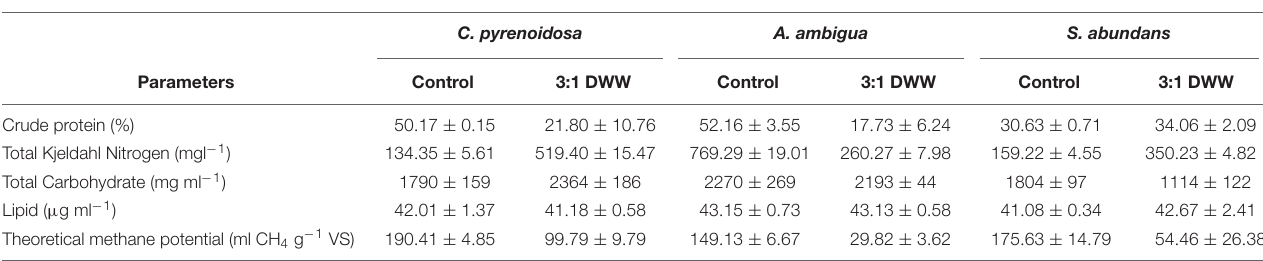
FIGURE 5 | Phosphate reduction at alternate of 5 days in 3:1 ratio of DWW treated with A. ambigua, C. pyrenoidosa and S. abundans ( (cid:7) -control; (cid:4) - C. pyrenoidosa ; (cid:78) - S. abundans ; - A. ambigua ) (Values represent the mean ± SD of three replicates). (cid:32) TABLE 4 | Biochemical characterization of algal biomass.